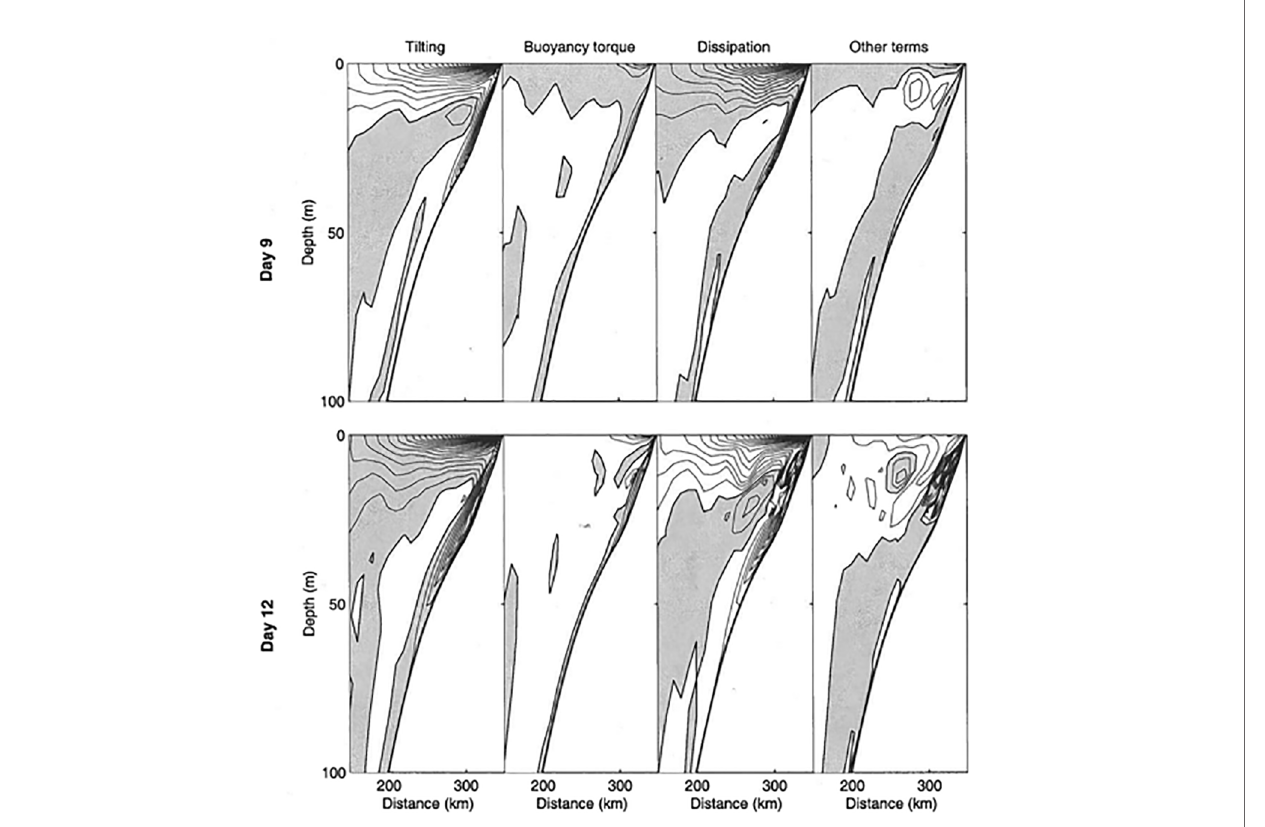
FIGURE 4 | Streamwise vorticity equation terms as functions of depth and offshore distance sampled at times of peak downwelling (upper panels) and upwelling (lower panels) in response to variable wind stress forcing from a Princeton Ocean Model simulation with realistic geometry, strati fi cation and wind forcing (from Weisberg et al., 2001). The contour interval is 10 -7 s -2 , clear regions are positive, shaded regions are negative, and the sloping bottom is the line that runs from the top right (the shoreline) to the bottom left of each panel. Note that the Tilting and Buoyancy torque terms have opposite sign for downwelling in the bottom Ekman layer, whereas they have the same sign for upwelling. Consequently, the bottom Ekman layer is thicker and more intensi fi ed (more contours) to provide more dissipation during upwelling than during